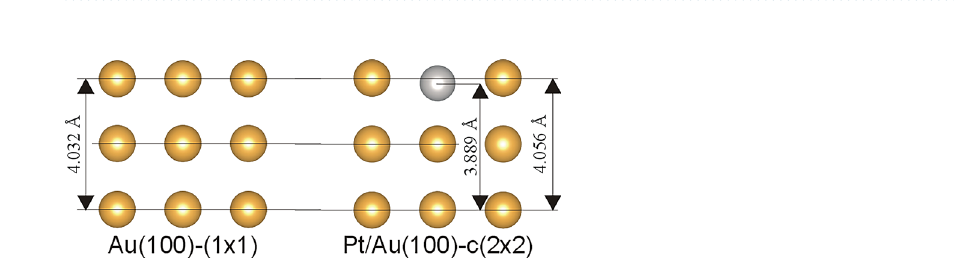
Figure 3. Geometry properties of the relaxed Au(100)-(1 × 1) and Pt/Au(100)-c(2 × 2)